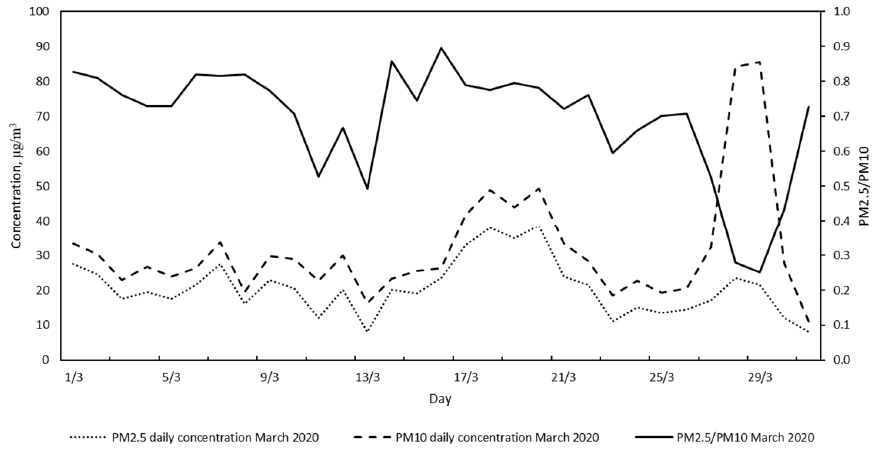
Figure 5. PM10 daily average (dashed black line), PM2.5 daily average (dotted black line), ratio between PM2.5 and PM10 (solid black line) measured in Milan by ARPA Lombardia, March 2020.